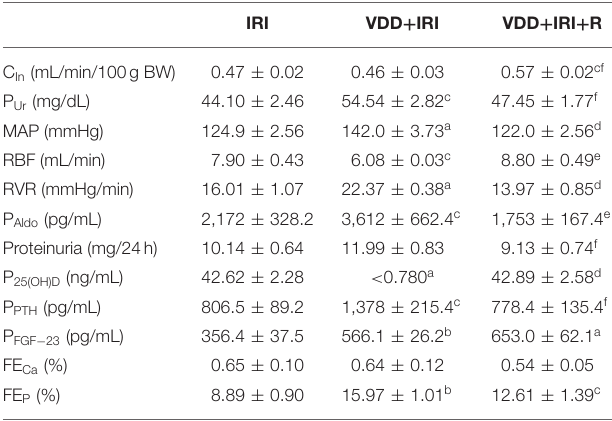
TABLE 1 | Renal function, hemodynamic and biochemical parameters evaluated in rats after 90 days of a bilateral 45min ischemia/reperfusion insult (IRI) on day